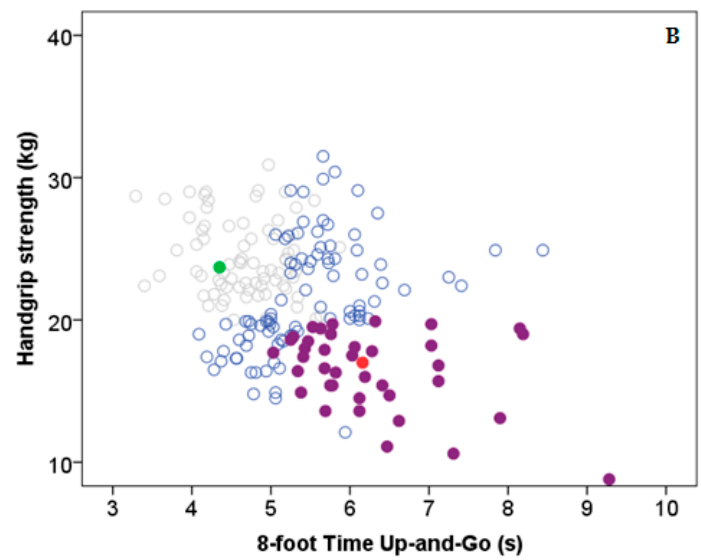
Figure 1. Scatter plot of variables used for diagnosis of sarcopenia: ( A ) men and ( B ) women. Grey open circles denote normal appendicular skeletal muscle index (ASMI, kg/m 2 ), 8-foot Time Up-and-Go (8-f TUG, s), and handgrip strength (HGS, kg). Grey solid circles denote presarcopenia. Grey open triangles denote high 8-f TUG or low HGS. Grey solid triangles denote high 8-f TUG and low HGS. Black open squares denote sarcopenia, and black solid squares denote severe sarcopenia.